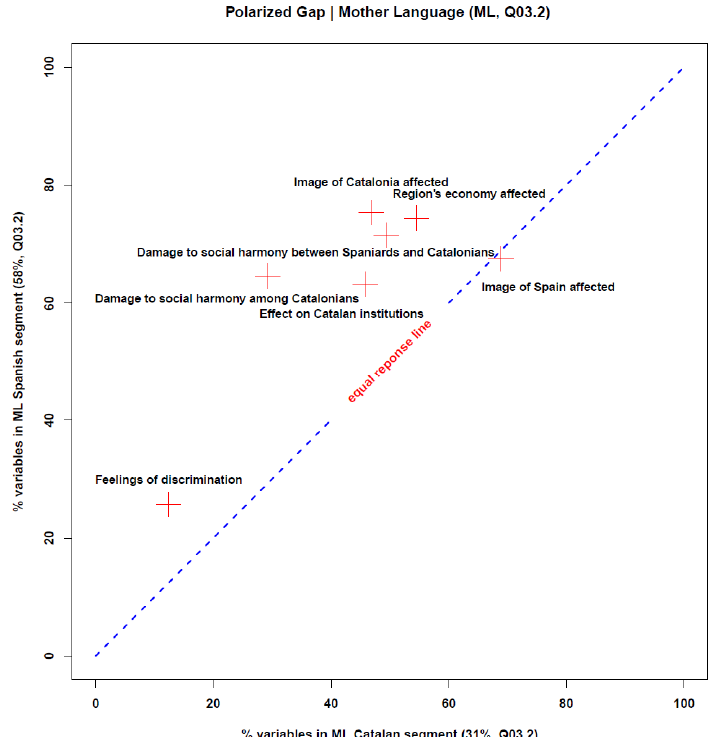
Figure 2. Differences among Catalonians depending on the “ mother language” segmentation in Table 3. The variables are sorted by their C values. The different colours of the figures correspond to p ‐ values that are less than 0.001 (red), between 0.001 and 0.01 (magenta), between 0.01 and 0.05 (black), or just over 0.05 (blue).